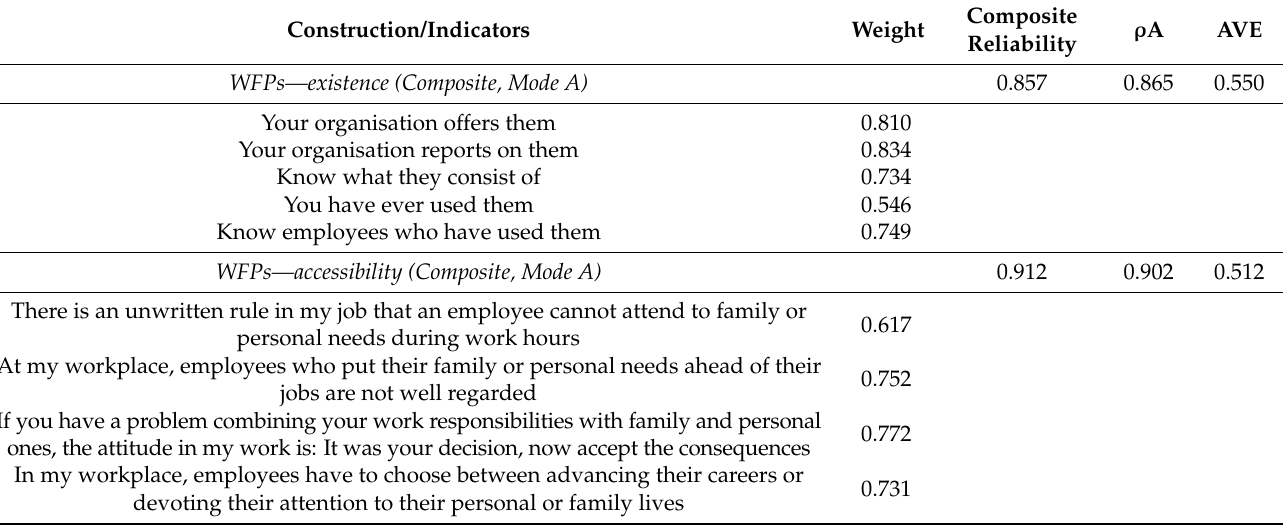
Table 2. Results of the measurement